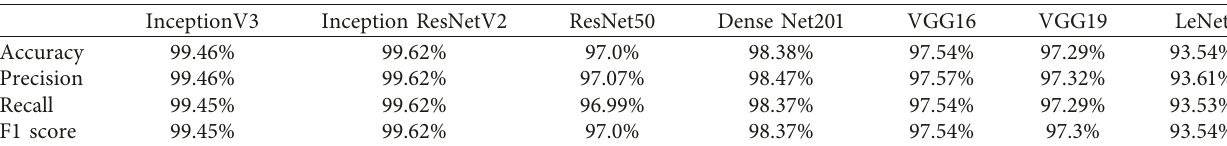
Figure 15: Accuracy and loss during CNN 3 training and validation. Table 3: Results obtained with architectures available in the